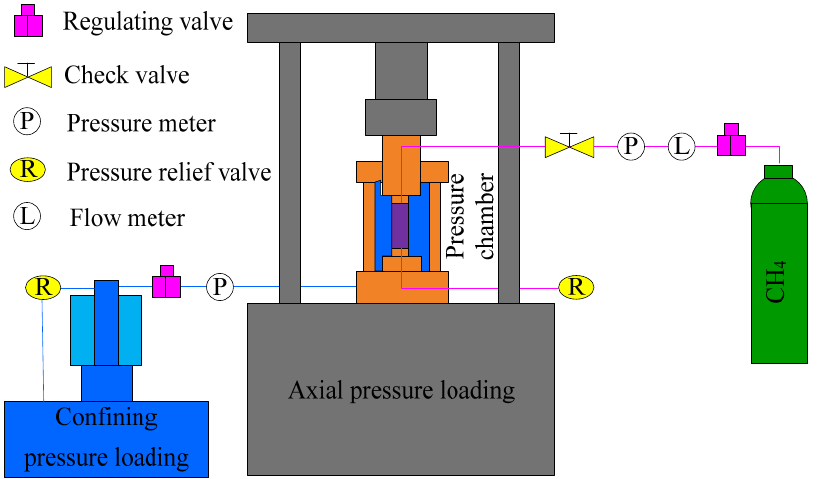
Figure 3. Schematic diagram of permeability measurement.